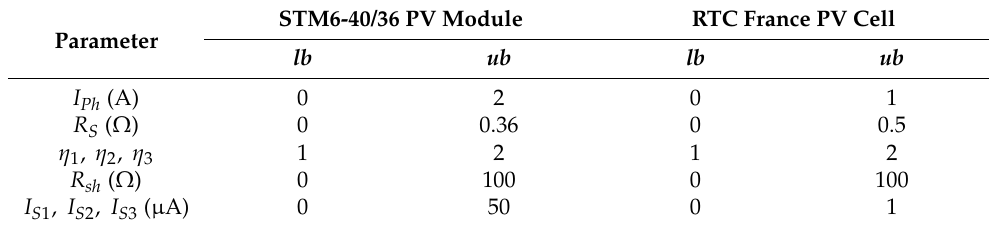
Table 1. Search range for the extracted parameters of PV modules under